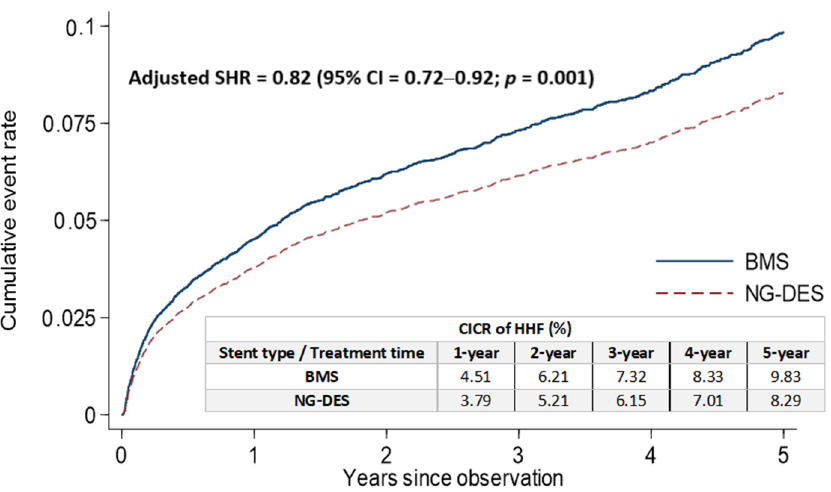
Figure 2. Cumulative incidence of HHF for competing risk among patients with STEMI receiving NG-DES or BMS implantation. BMS—bare-metal stent; CI—confidence interval; CICR—cumulative incidence competing risk; HHF—hospitalization for heart failure; NG-DES—new-generation drug- eluting stent; SHR—subdistribution hazard ratio; STEMI—ST-elevation myocardial infarction.